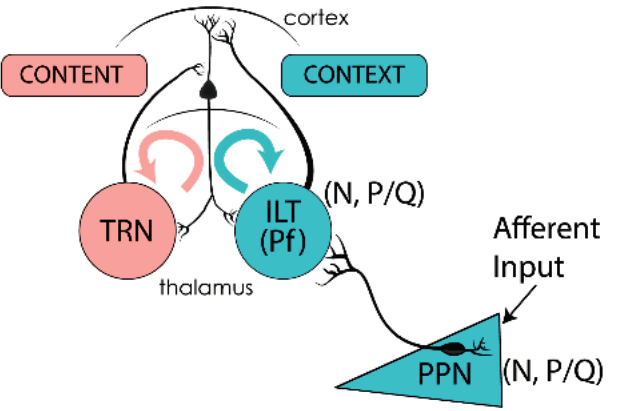
Figure 4. Gamma band activity in the RAS and ascending targets. Afferent sensory information impinging on dendrites with high threshold calcium channels induces gamma band activity in PPN neurons. PPN output during REM sleep (N + P/Q and N-only cells) activate SubCD neurons with sodium-dependent subthreshold oscillations (STO), which in turn travel to the hippocampus and descending targets. PPN output during waking (N + P/Q and P/Q-only cells) activate the dendrites of parafascicular (Pf) cells in the intralaminar thalamus (ILT) that also bear high threshold calcium channels in the dendrites [4,5]. Gamma band activity from the “non-specific” ILT travels to upper layers of the cortex to supply the “CONTEXT” of sensory input, while “specific” thalamic relay neurons (TRN) send information to layer IV of the cortex to provide the “CONTENT” of sensory experience. The resulting thalamocortical oscillations based on coincident firing provides conscious perception